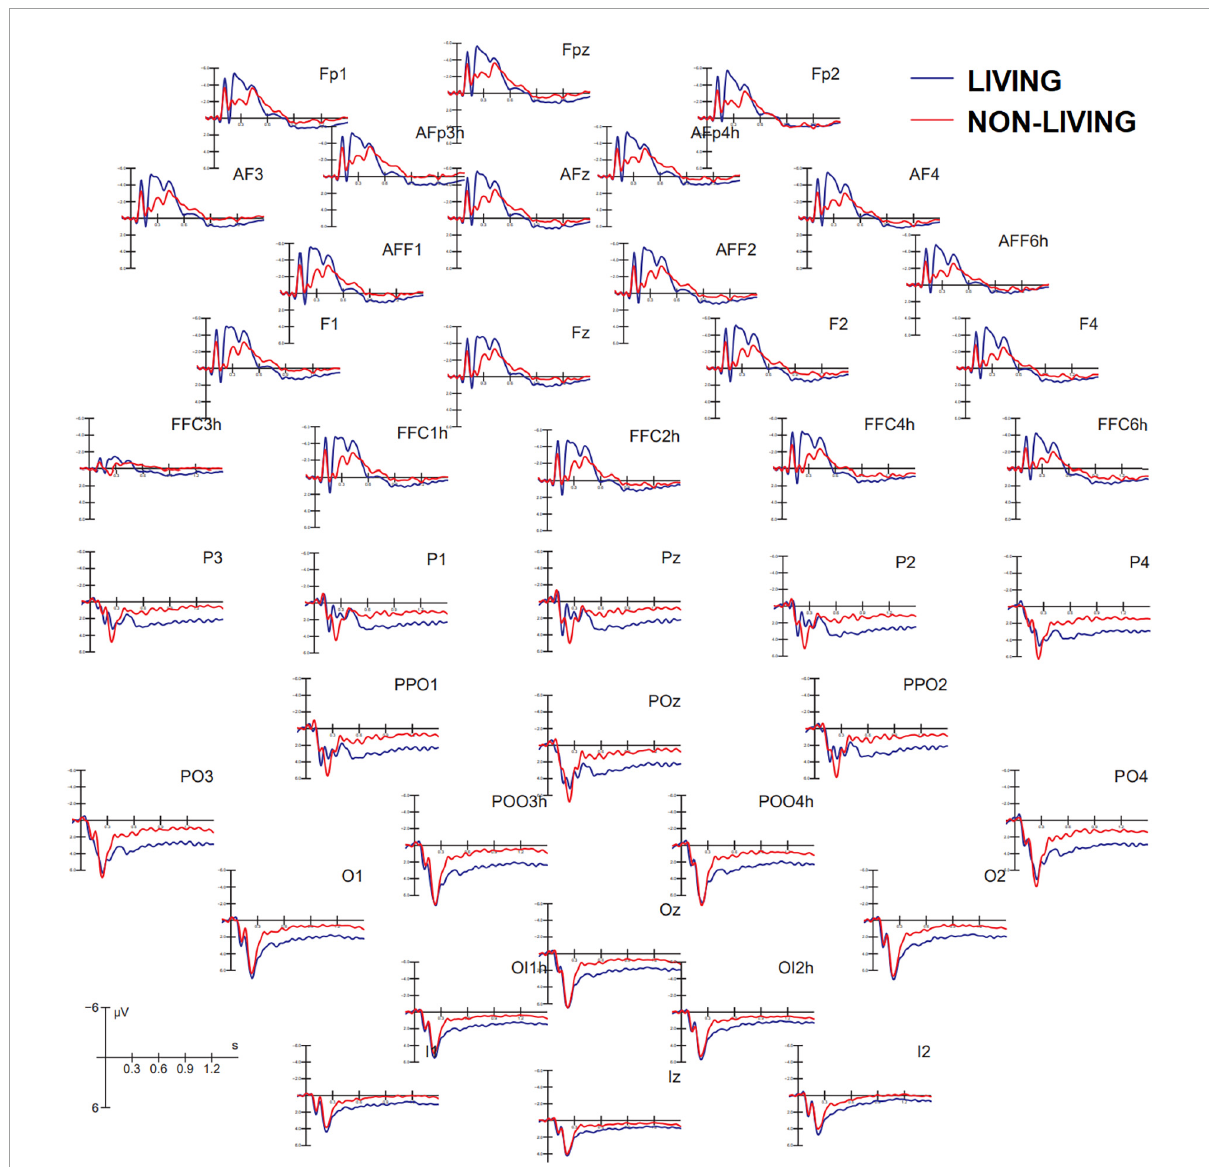
FIGURE3 Grand average ERP waveforms recorded at anterior (top) and posterior (bottom) scalp sites as a function of stimulus category. ERPs to living items were obtained by averaging together ERPs elicited by faces, bodies, and animals, while ERPs to non-living items were obtained by averaging ERPS elicited by checkerboards, written words, and